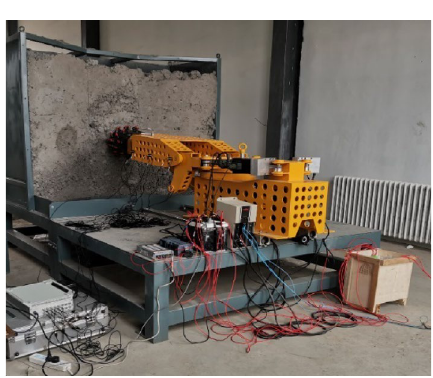
Figure 14. Test bed for the cutting head-coal rock system.